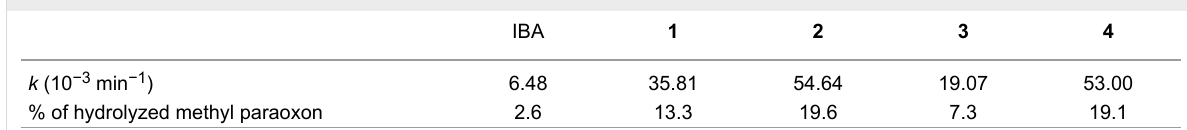
Table 1: Estimated pseudo-first-order rate constant ( k ) and amount (%) of hydrolyzed methyl paraoxon over the first 4 minutes. a